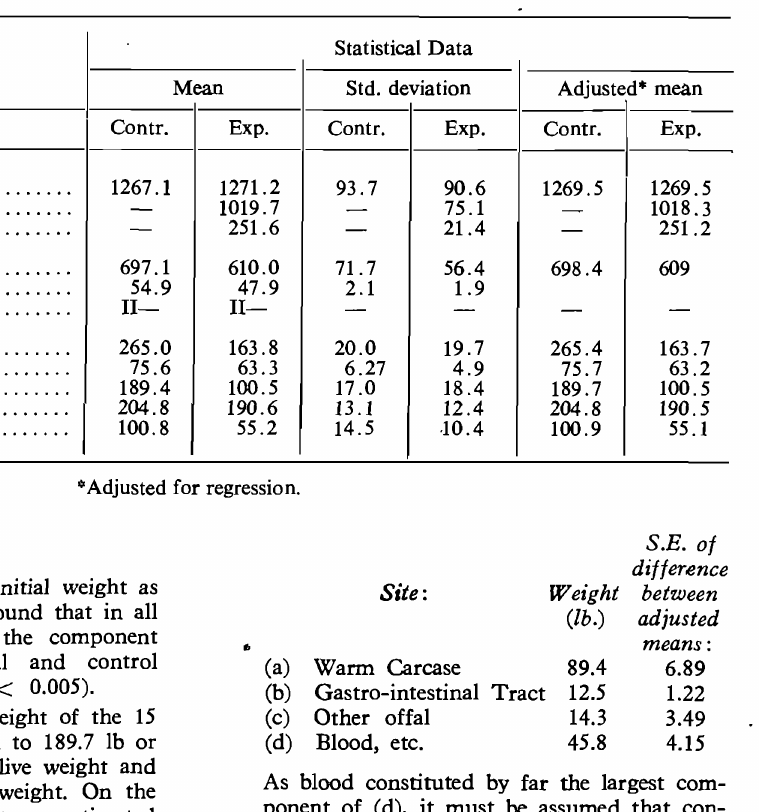
TABLE 2.-SUMMARY OF LIVE WEIGHTS (LB) AND SLAUGHTER DATA OF CONTROL AND EXPERIMENTAL STEERS. Statistical